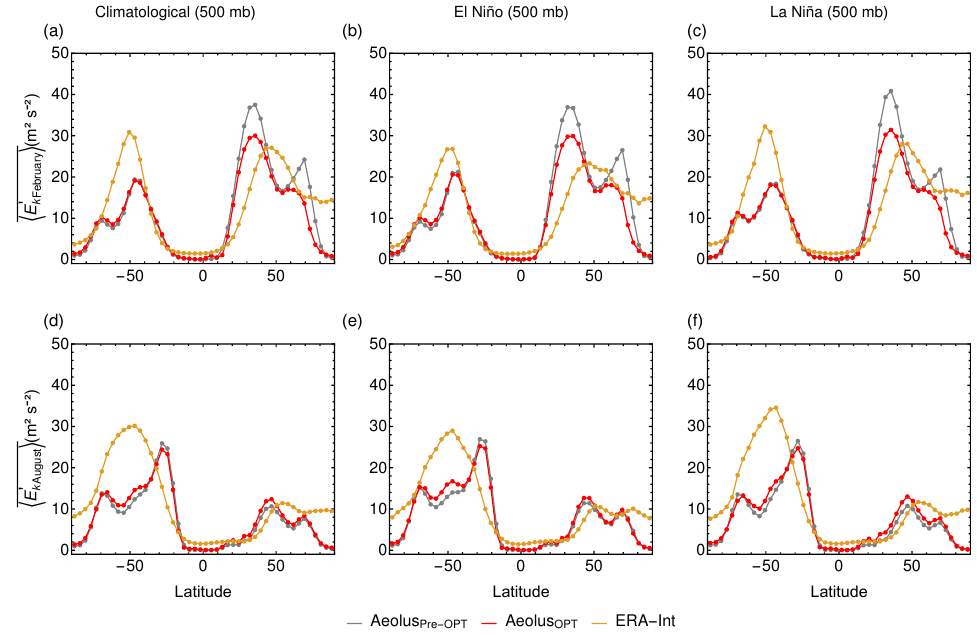
Climatological ( 500 mb )